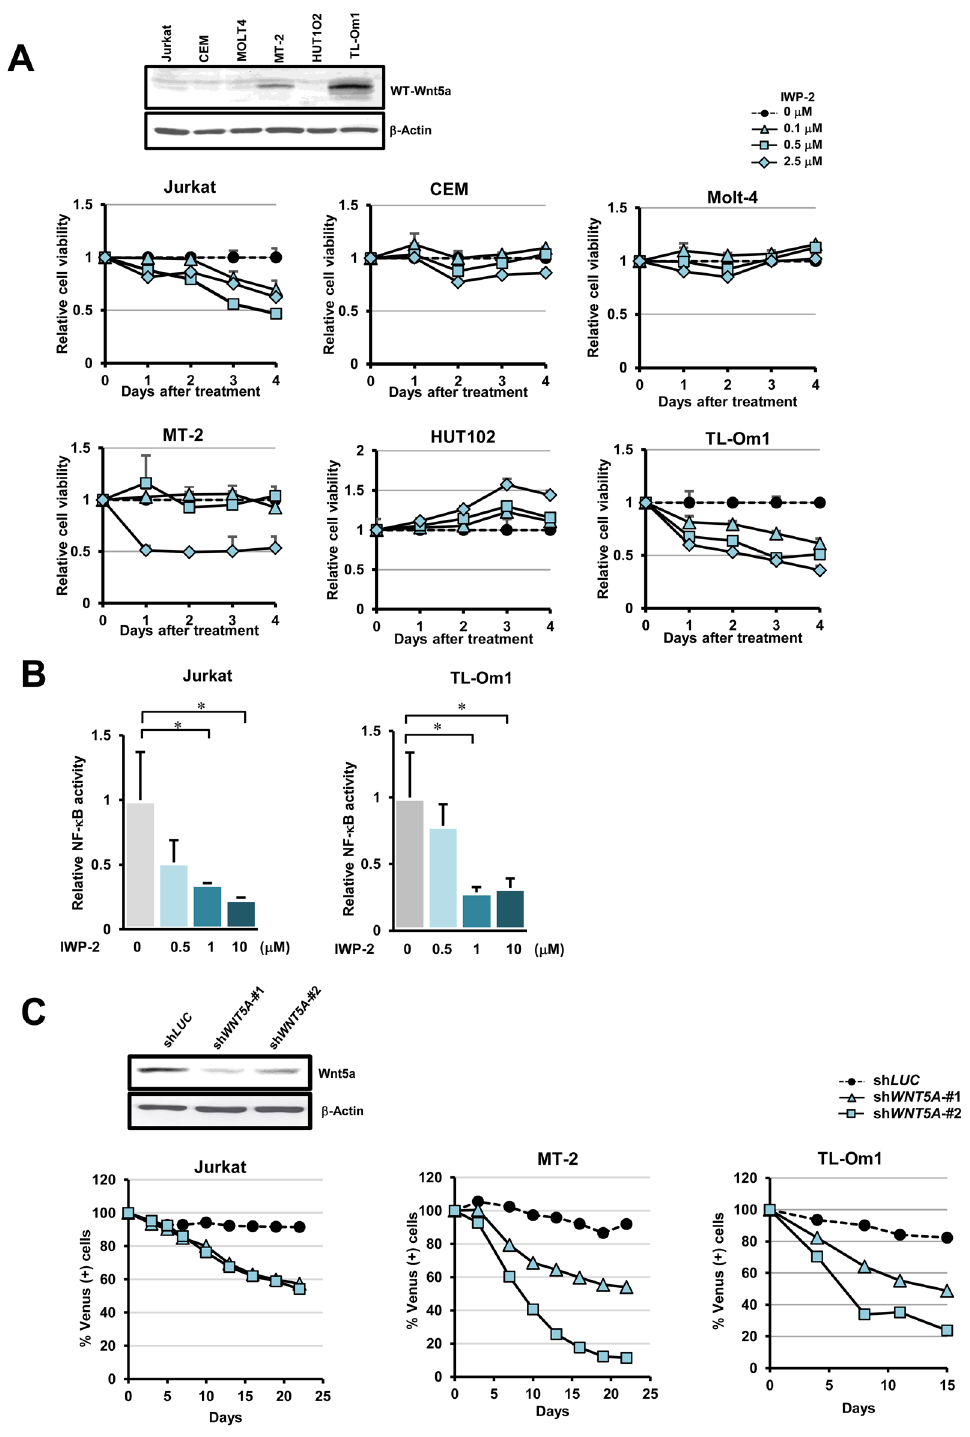
Figure 2. Wnt5a dependent NF-κB activation and cell growth. ( A ) IWP-2 treatment in Jurkat, CEM, Molt-4, MT-2, HUT102, and TL-Om1 cells. The dose-dependent suppression of cell growth was observed in MT-2 and TL-Om1, which expressed high levels of Wn5a protein (the upper panel). Please note that the upper panel consists of two pictures from two separated blots for Wnt5a and β-Actin, respectively, which are clearly separated by black frames. ( B ) IWP-2 treatment significantly and dose-dependently suppressed cellular NF-κB activities in Jurkat and TL-Om1 cells (n = 6, mean ± SD, * P < 0.05). ( C ) Specific knockdown of Wnt5a expression (the upper panel) by shRNA against WNT5A mRNA in Jurkat, MT-2, and TL-Om1 significantly reduced the cellular survival rates. Please note that the upper panel consists of two pictures from two separated blots for Wnt5a and β-Actin, respectively, which are clearly separated by black frames. The graphs show the course of changes in the percentage of Venus (+) cells, i.e., Wnt5a knockdown cells, after the recombinant lentivirus infection. The % Venus (+) cells in sh WNT5A expressing cells decline rapidly during infection, while that with sh LUC (the negative control) does not. The induction of cell-death in Wnt5a knockdown cells were more significant in MT-2 and TL-Om1 cells than Jurkat, in agreement with IWP-2 treatments in ( A